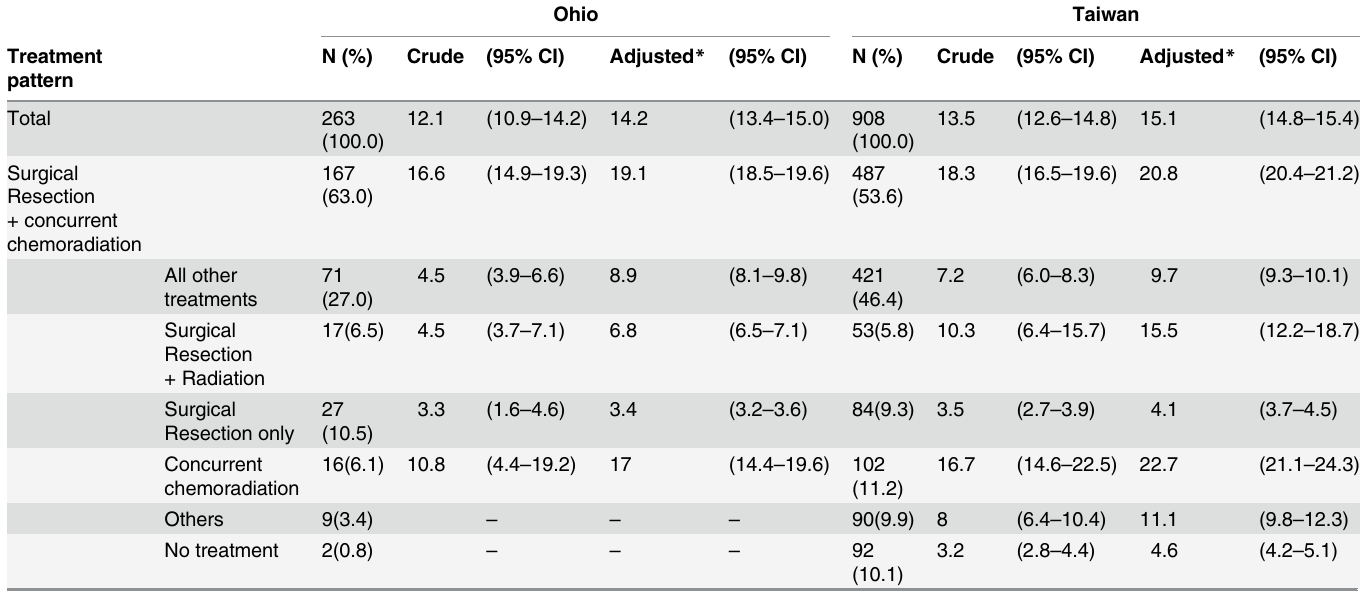
Table 4. Median Survival Time (Months) of Patients with Glioblastoma in Ohio and